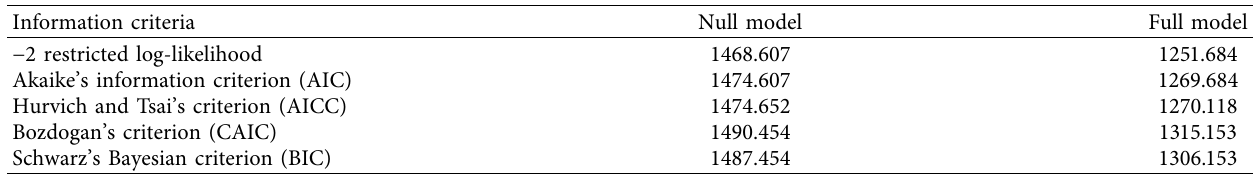
Table 15: The information criteria output from the takeover time model by gender and